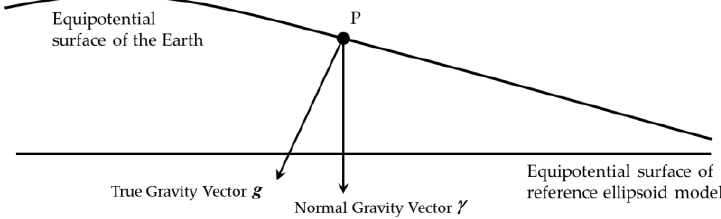
Figure 3. The definition of gravity disturbance vector, gravity disturbance and deflection of vertical.